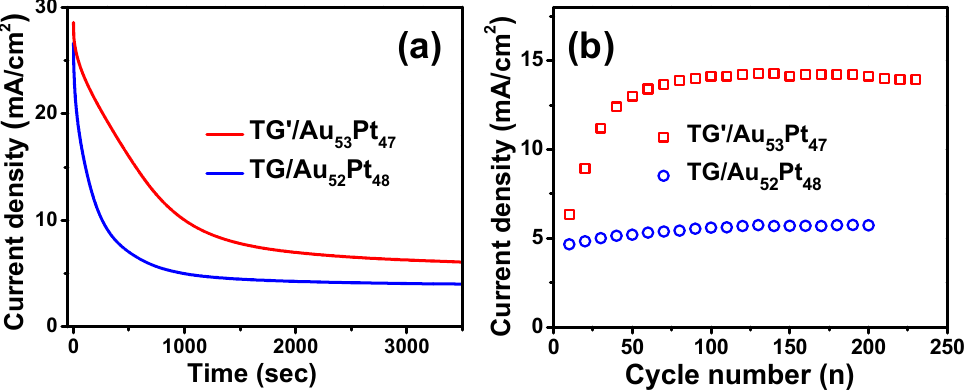
Figure 10. ( a ) Chronoamperometric curves measured at 1 V (vs. RHE) and ( b ) peak current densities of methanol oxidation in the forward scan vs. the cycle number of the TG/Au 52 Pt 48 and TG’/Au 53 Pt 47 catalysts.